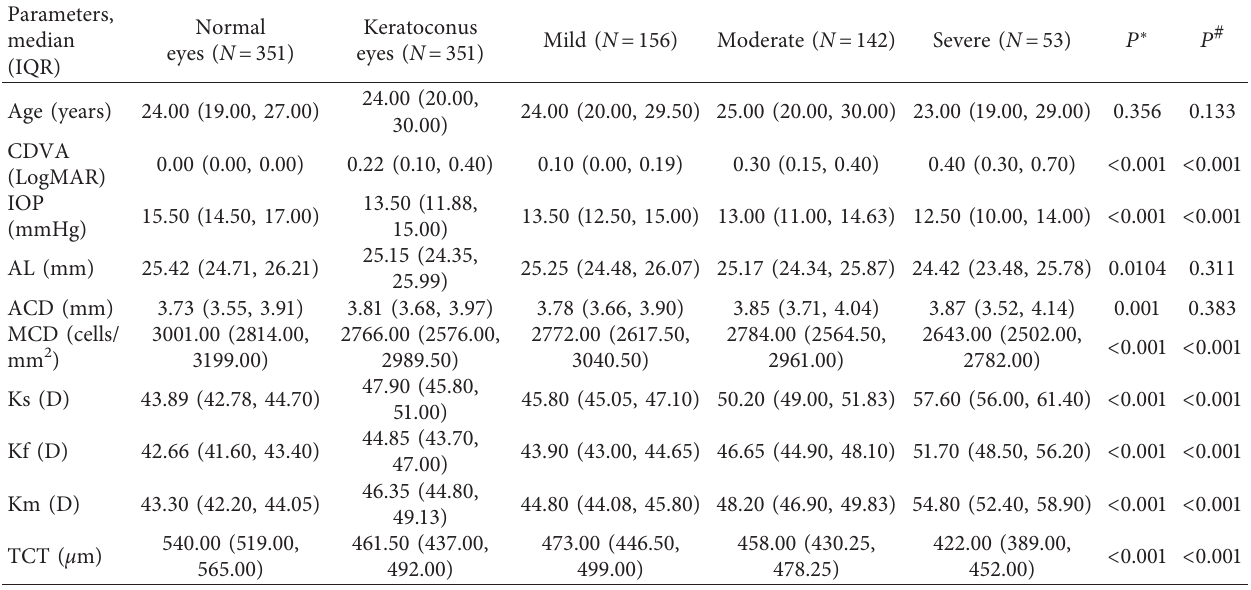
Table 1: Clinical parameters of normal and keratoconus eyes.